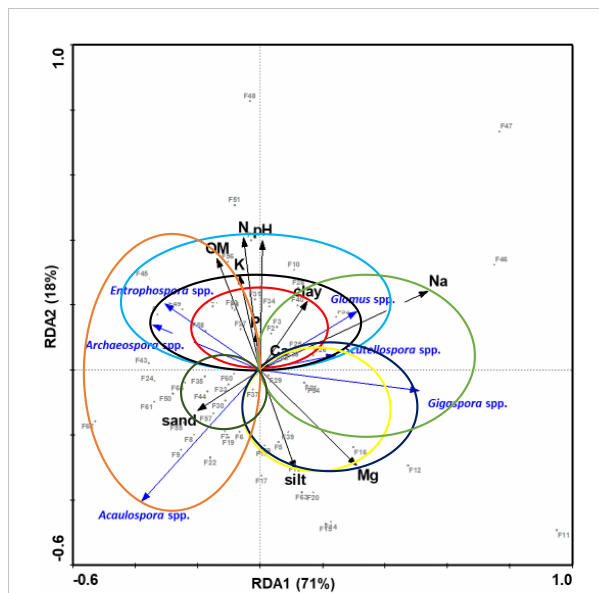
FIGURE 4 RDA (canonical correlation analysis) biplot of the 6 arbuscular mycorrhizal fungi genera ( Glomus , Scutellospora , Gigaspora , Acaulospora , Archaeospora and Entrophospora ) and soil properties from the sampled fi elds. The circle ’ s diameter is equal to the length of the soil property ’ s arrow. Genera lines that end in that circle have a positive regression for that soil property. The length of the arrow indicates increasing in fl uence and the smaller the angle between the two arrows indicates closer